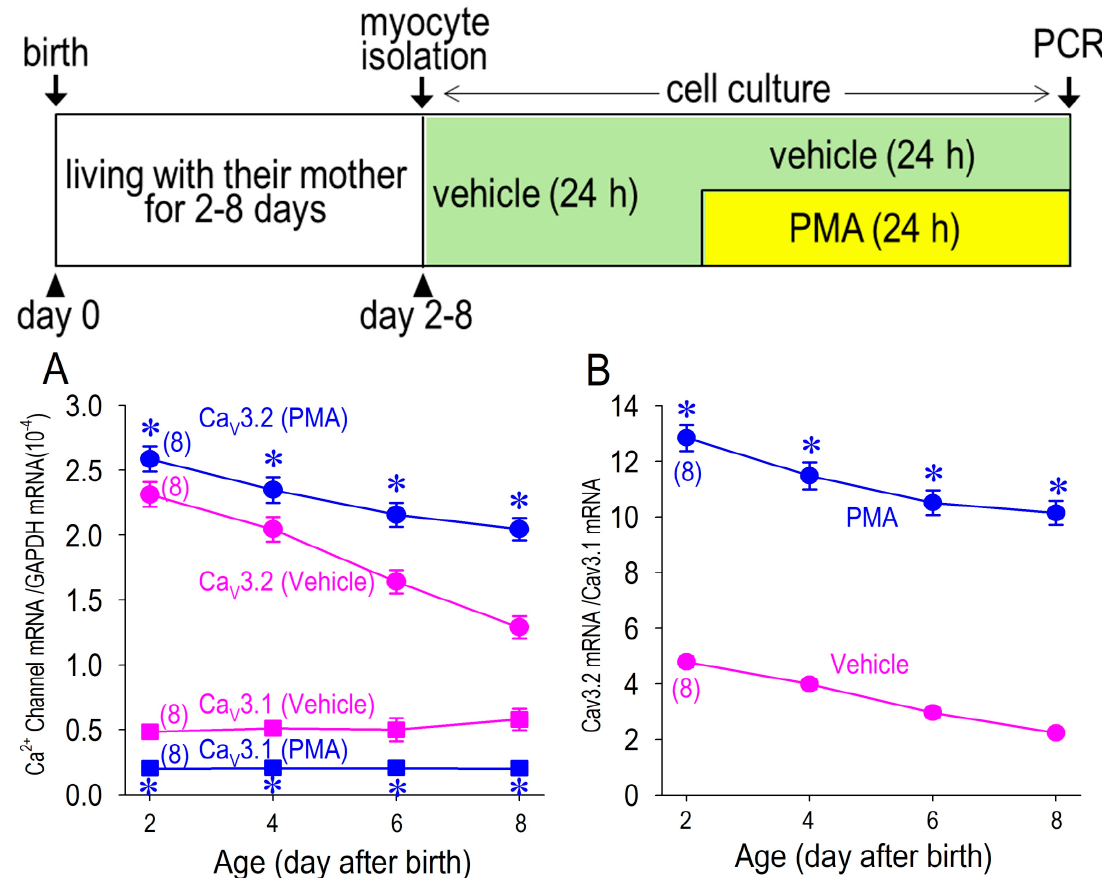
Figure 7. Changes of the levels of Cav3.1 and Cav3.2 -mRNA expression in myocytes. Expression of Cav3.1 and Cav3.2 mRNA was assessed by real-time PCR in myocytes isolated at day 2, 4, 6 and 8, treated in vehicle or 1 μ M PMA ( A ). The same data for Cav3.2 mRNA from Figure 5C replotted. Time-dependent changes of Cav3.2 mRNA/Cav3.1 mRNA were assessed in cells treated in vehicle or 1 µ M PMA ( B ). Note that PMA was washed out in the culture medium prior to the electrophysiological study. Data were expressed as mean ± S.D. ( n = 8). * p < 0.05, compared with those in vehicle at the same age. Protocols for myocytes isolation and cell culture are shown in the inset above. Numbers of experiments are given in parentheses.